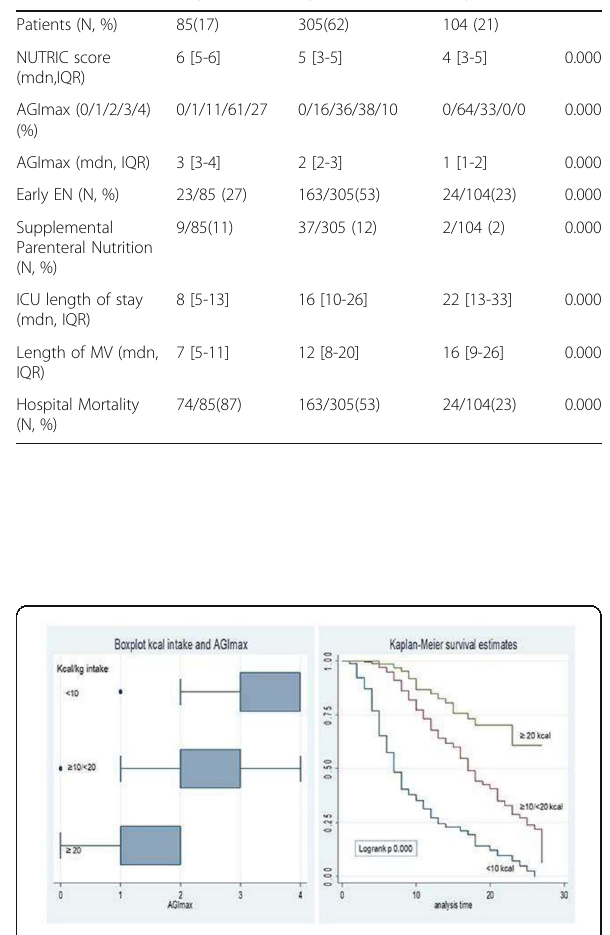
Fig. 1 (abstract 0042). Boxplot AGImax and caloric intake and K-M for hospital mortality and caloric intake